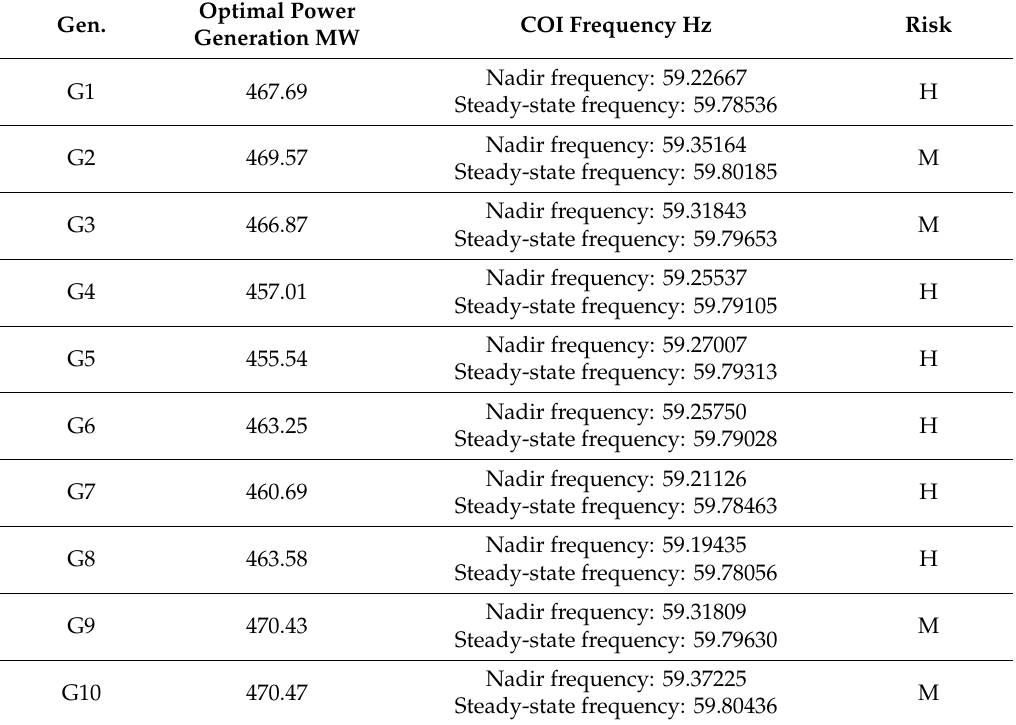
Table 6. IPM-OPF based optimal power generation and frequency response for contingency.